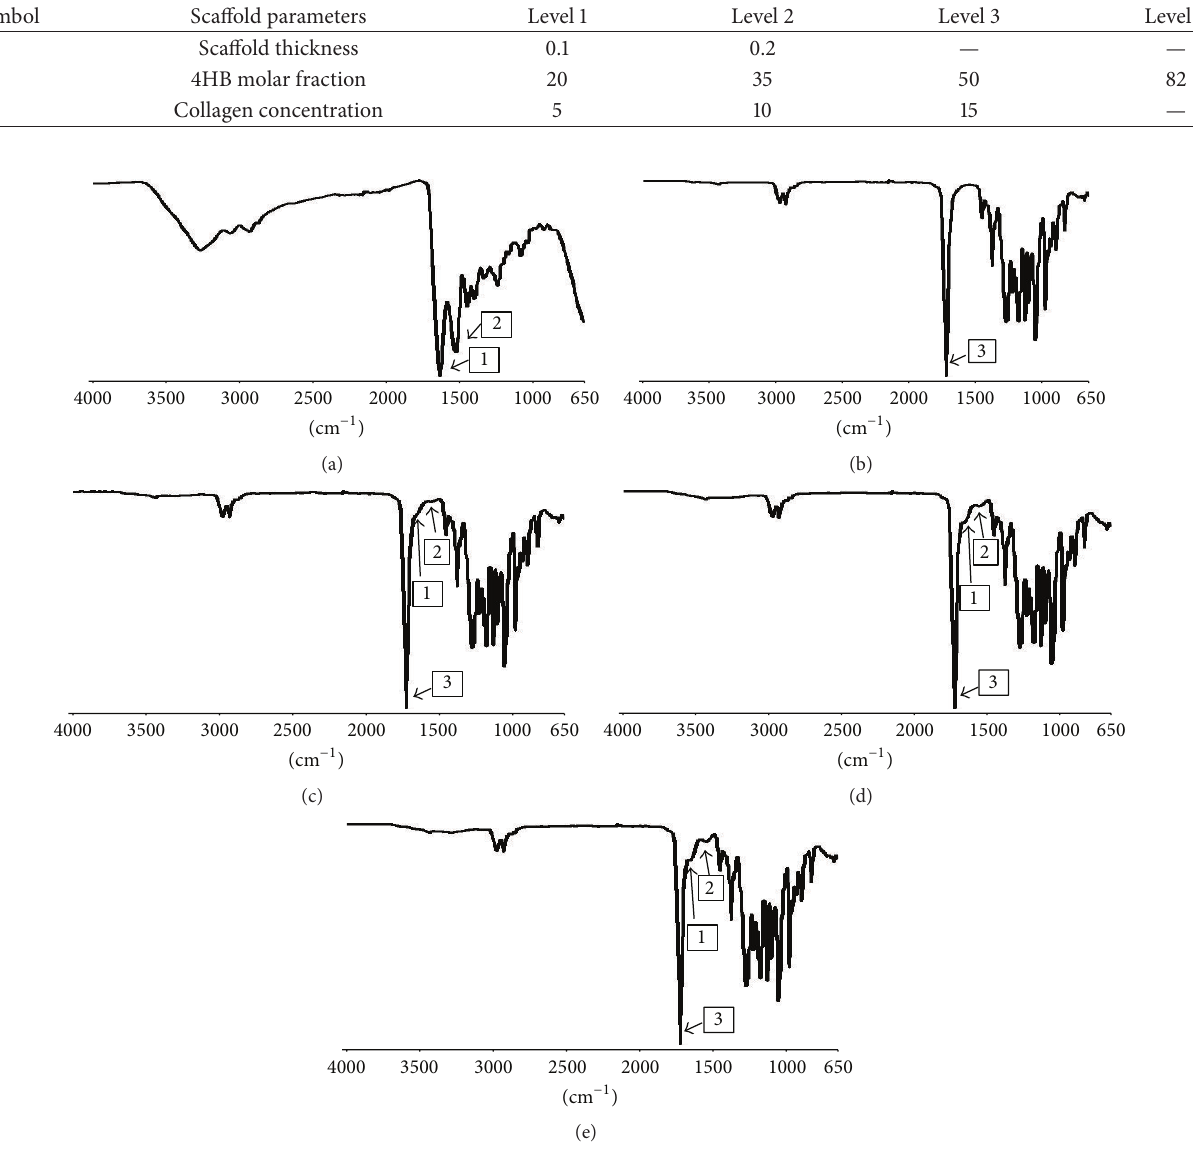
Figure 1: FTIR spectra of simple blend scaffolds: (a) collagen, (b) P(3HB- co -4HB), (c) P(3HB- co -4HB)/5wt% collagen, (d) P(3HB- co - 4HB)/10wt% collagen, and (e) P(3HB- co -4HB)/15wt% collagen. Arrows 1, 2, and 3 indicate amide I, amide II, and ester group,